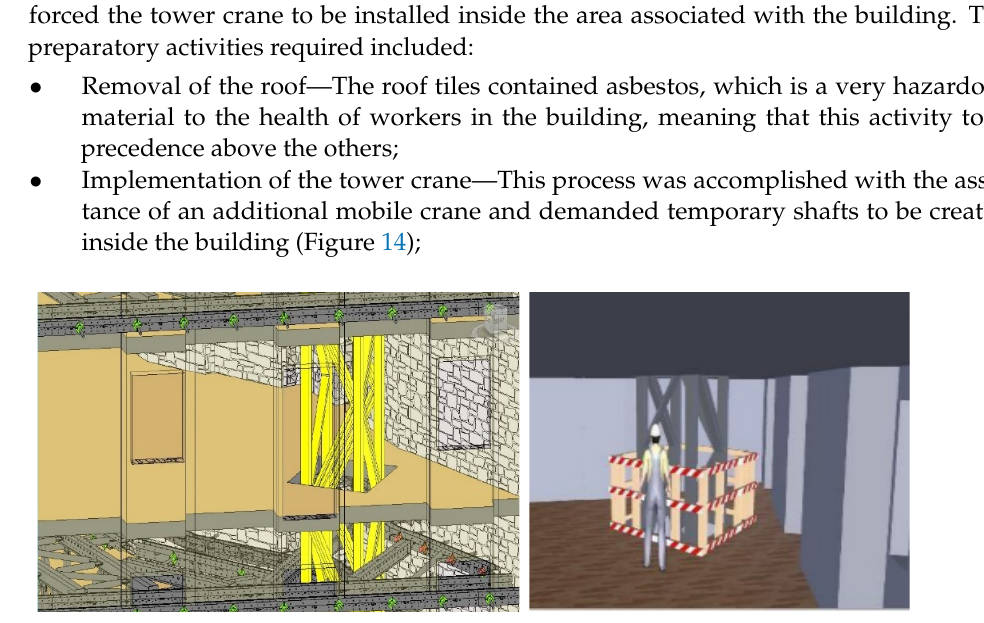
Figure 13. Definition of openings, insertion of the tower crane, and the real equipment in place.